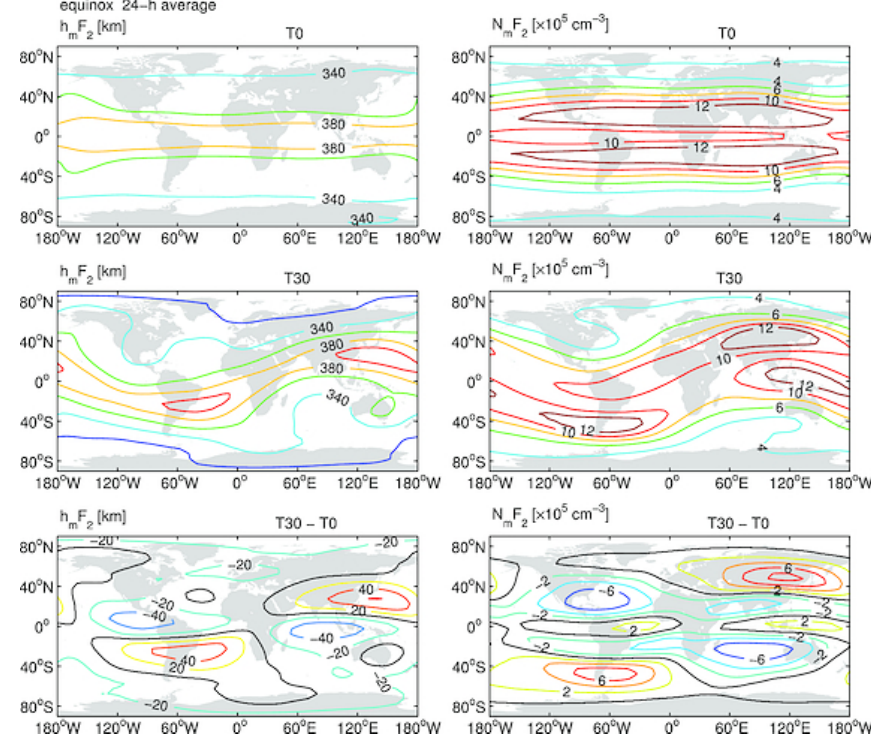
Figure 13. Maps of the 24 ‐ h mean height of the F2 peak, hmF2 (km), and the peak electron density of the F2 layer, NmF2 ( × 10 5 cm − 3 ) for T0, T30, and the difference (T30–T0) for March equinox and southward IMF. (Reproduced from Cnossen and Richmond [18]: Figure 7).